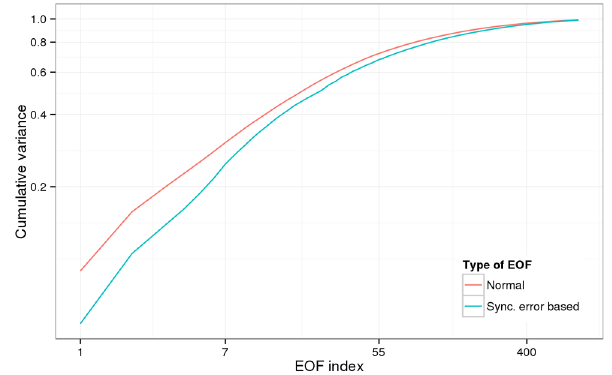
Fig. 4. Cumulative fraction of explained variance of both EOF op- tions versus the number of EOFs. Note that both the x- and the y- axis are on a log